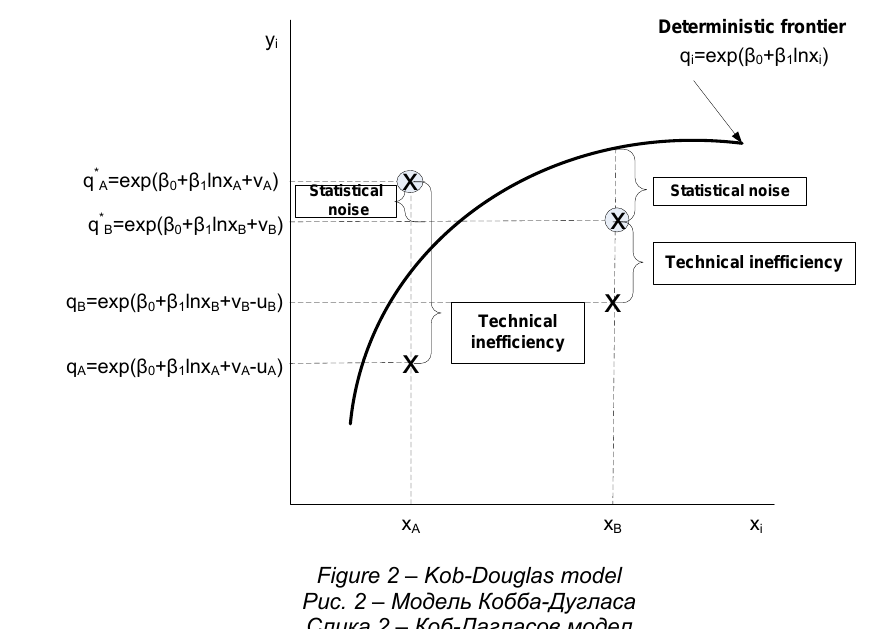
Figure 2 – Kob-Douglas model Рис . 2 – Модель Кобба - Дугласа Слика 2 – Коб - Дагласов